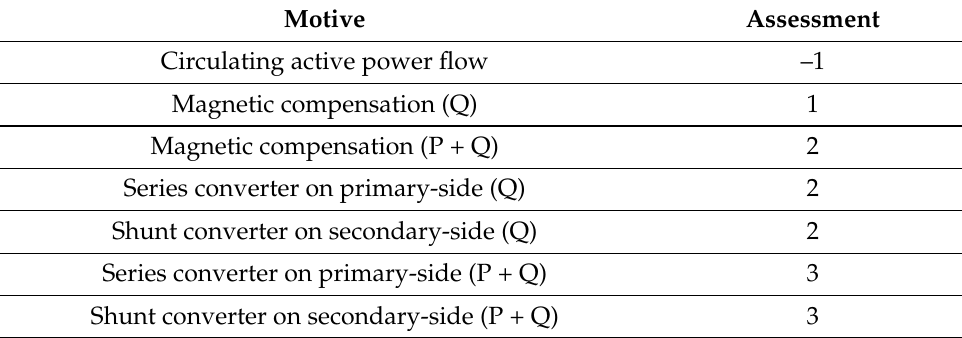
Table 4. LFT protection